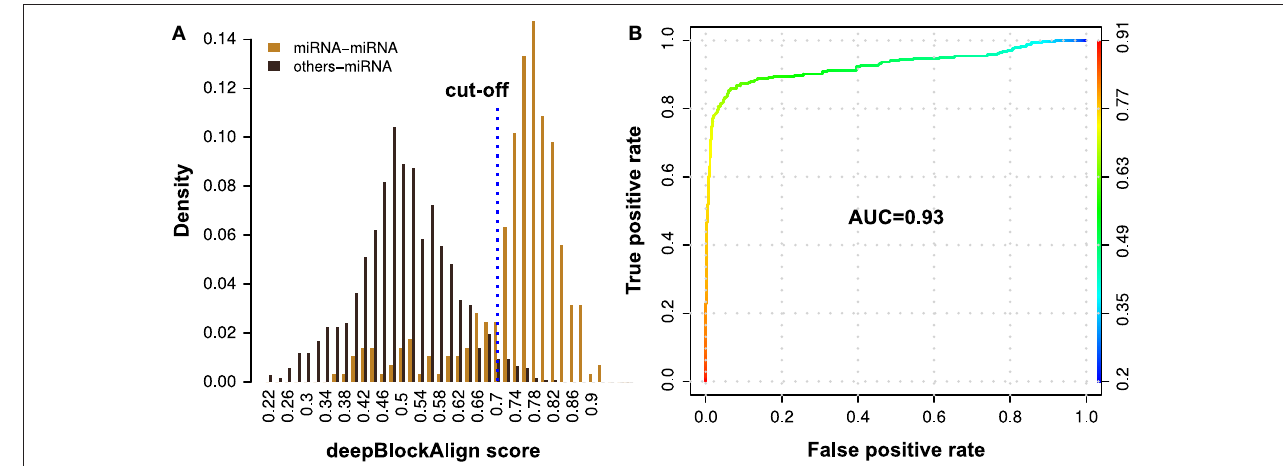
FIGURE 4 | Performance evaluation of the proposed method for the prediction of putative miRNAs using alignment of read profiles. (A) Density distribution of deepBlockAlign alignment scores for 285 miRNA (orange) and 1076 other ncRNA (black) read profiles from ENCODE dataset against miRNA read profile database (miRRPdb), respectively. We observed two distinct score distributions comprised of most miRNAs (223 out of 285)